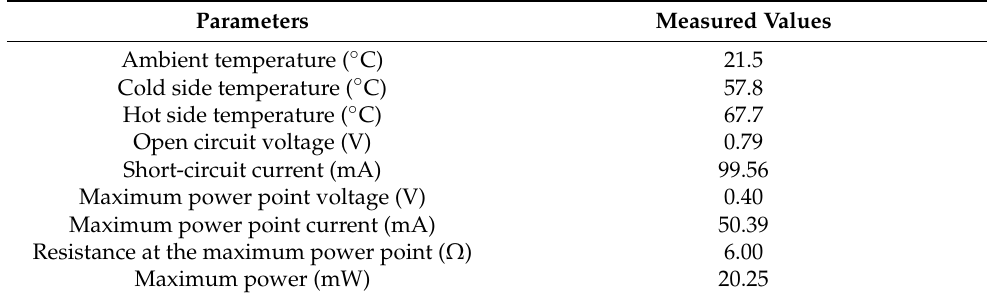
Table 4. Parameters of the analyzed TEG module.